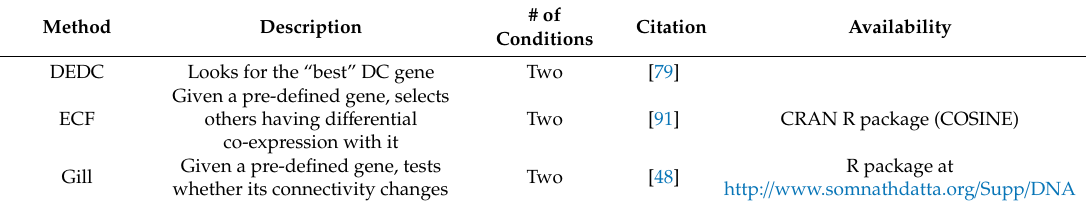
Table 4. “Single-gene”